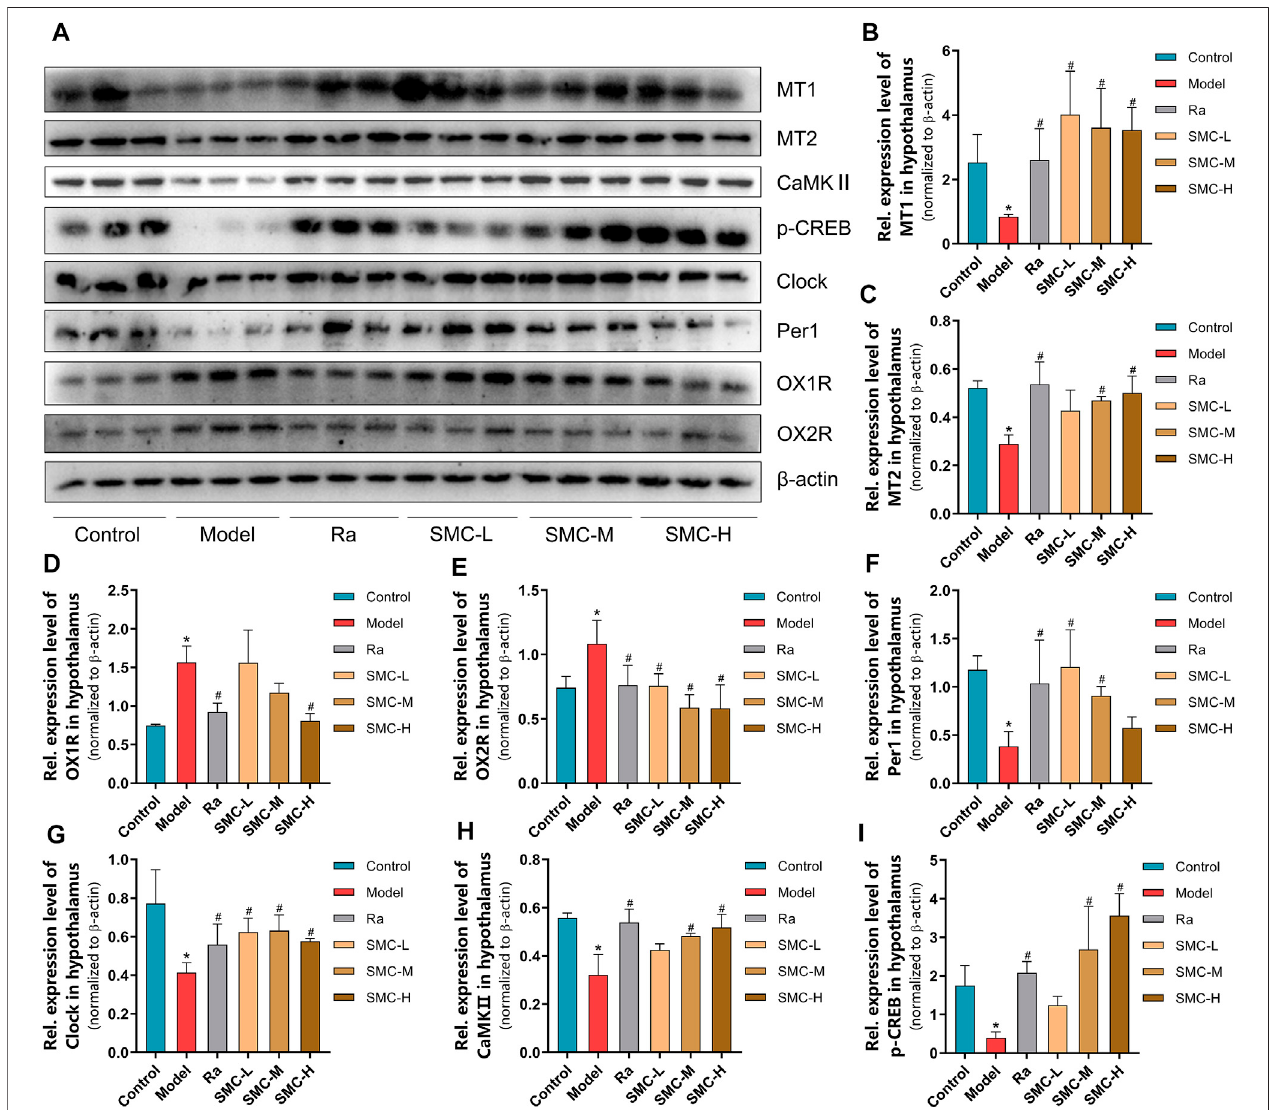
FIGURE6| Thechangesofmelatoninreceptorsandtheirrelatedproteinsinsleep-deprivedmiceafterbeingtreatedwithramelteonanddifferentdosesofSMC( n = 3). (A) Western blotting results. Statistical dataoftheMT1 levels (B) ,the MT2levels (C) ,the OX1R levels (D) ,theOX2R levels (E) ,thePer1 levels (F) ,theclock levels (G) , the CaMK Ⅱ levels (H), and the p-CREB levels (I) . * p < 0.05 vs . control group; # p < 0.05 vs . model group. All the data were represented as the mean ± SD.